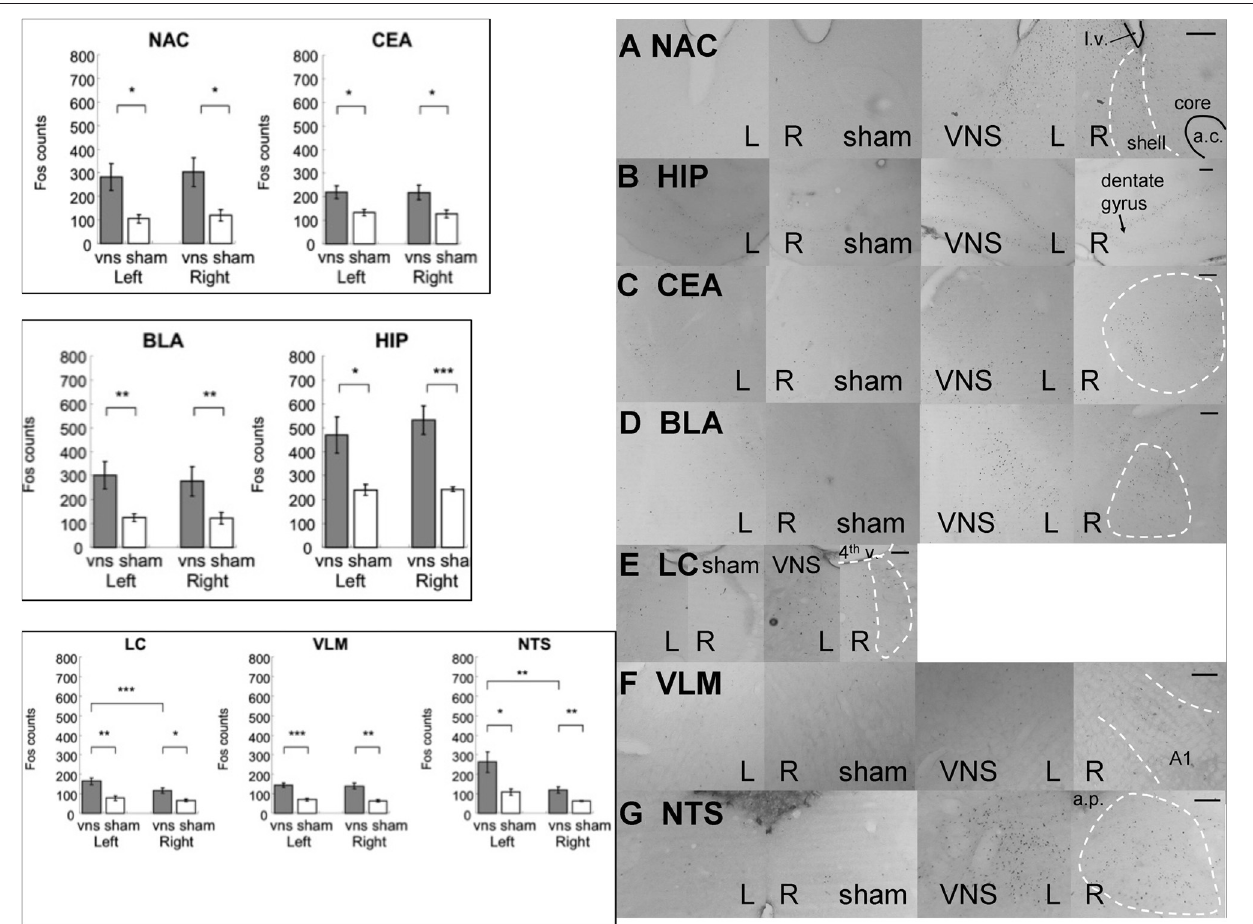
Photomicrographs of Fos labeling in the NAC (A), HIP (B), CEA (C), BLA (D), LC (E), VLM (F), and NTS (G) following sham or vagus nerve stimulation. Scale bar = 200um. (l.v.: lateral ventricle; a.c.: anterior commisure; shell: the shell region of the nucleus accumbens; core: the core region of the nucleus accumbens; 4 th v.: the fourth ventricle; a.p.: area